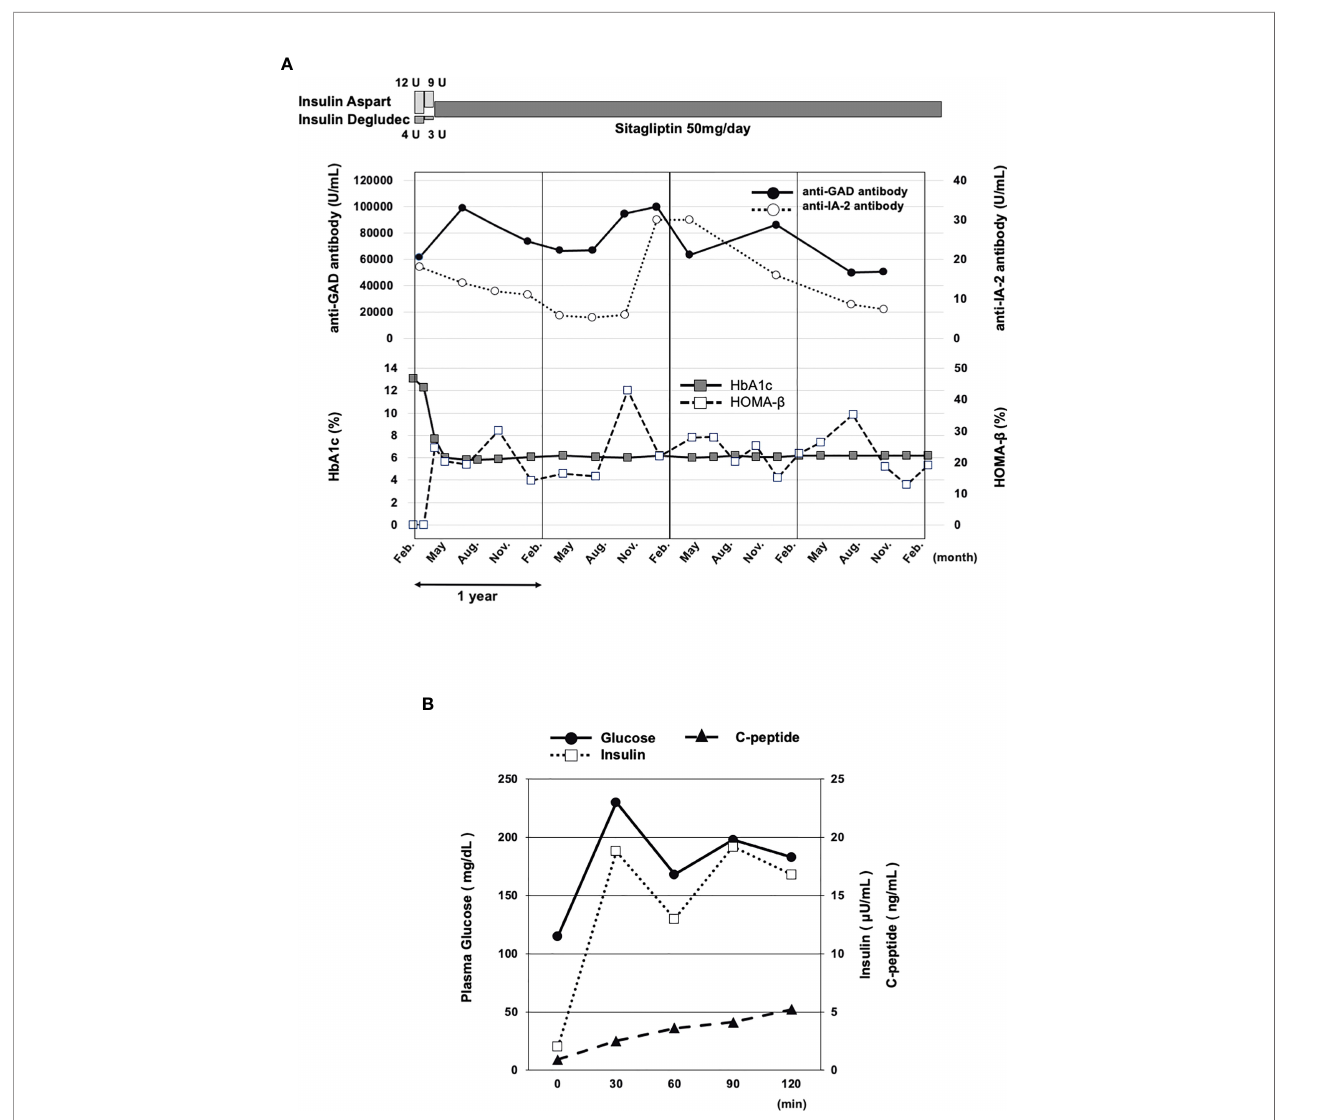
FIGURE 1 | (A) Time course of clinical parameters in this subject. On admission, we started insulin therapy. About 3 months later, we stopped insulin therapy and changed to 50 mg of sitagliptin. His good glycemic control continued, although his anti-GAD antibody and anti-IA-2 antibody titers were very high for over 4 years. HOMA- b showed his b -cell function was retained, although it was decreased. (B) Seventy- fi ve grams of oral glucose tolerance test in this subject 4 years after being diagnosed of T1DM. His insulin secretory capacity was preserved, although it was decreased. HbA1c, hemoglobin A1c; HOMA- b , homeostatic model of assessment- b ; GAD, glutamic acid decarboxylase; IA-2, insulinoma-associated